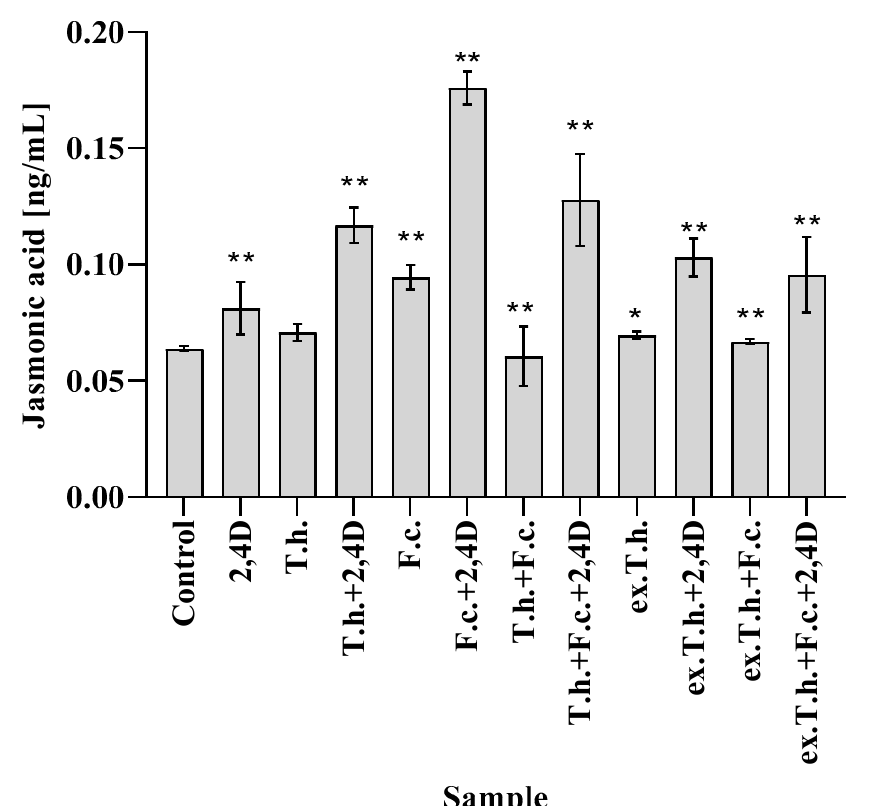
Figure 4. The contents of jasmonic acid in shoots measured after 7 days of cultivation (T.h.— T. harzianum -inoculated wheat seeds; F.c.— F. culmorum -inoculated wheat seeds; ex.T.h.— T. harzianum extracellular metabolite-treated wheat seeds). Data represent means ± SE; the significance of the variance study with Tukey’s post hoc test = * p ≤ 0.01, ** p ≤ 0.001. The subcolumn comparison is attached in supplementary material as Table S4.